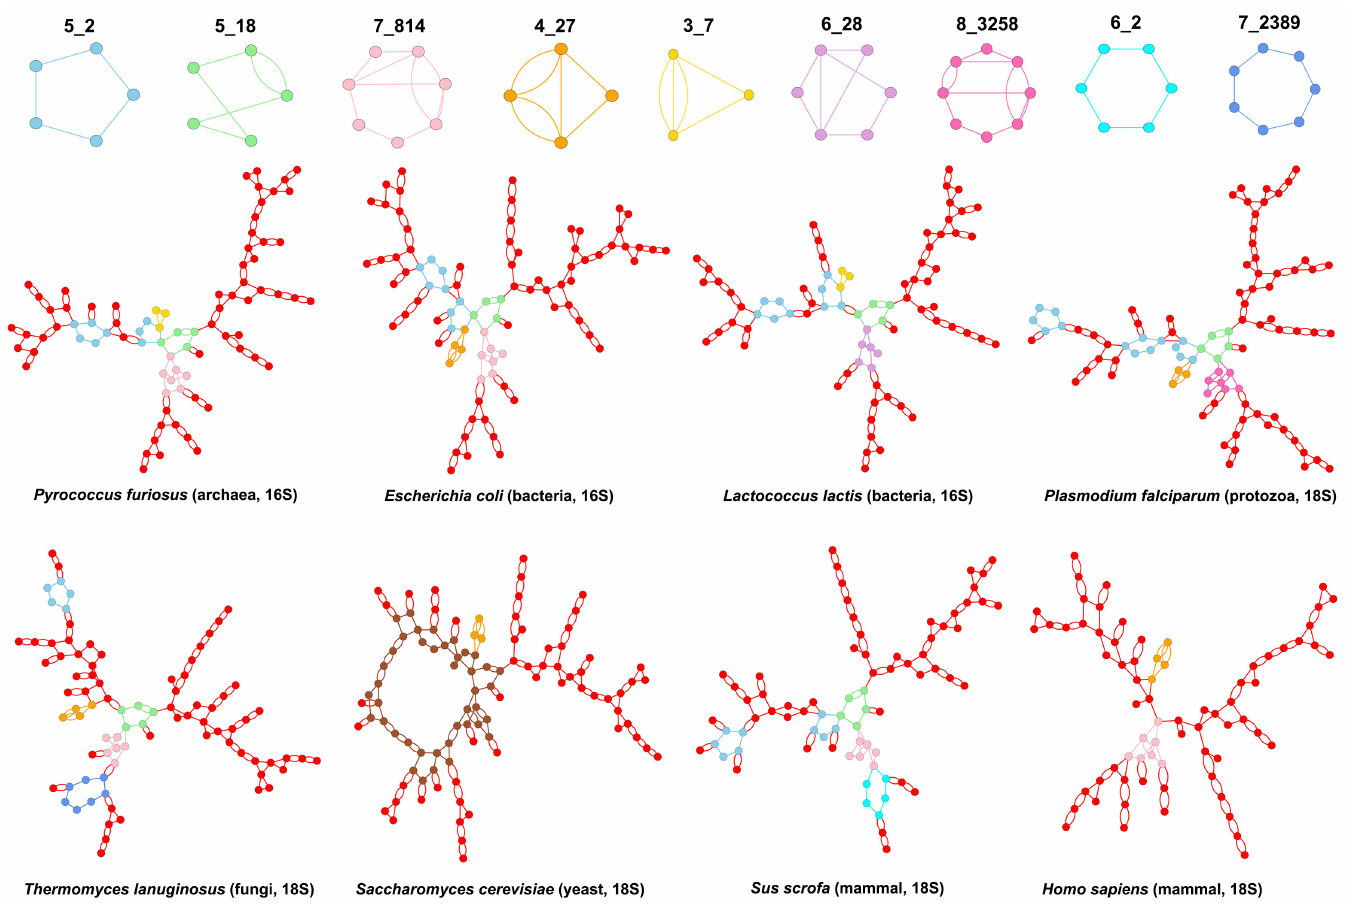
Figure 9. Dual graphs for small subunit rRNAs. Dual graphs corresponding to the 16S (prokaryotes) and 18S (eukaryotes) rRNAs of small ribosomal subunits for a few representative species. Different colors highlight different subgraph blocks. The subgraph block with 41 vertices in the dual graph of Saccharomyces cerevisiae is highlighted in brown. Smaller subgraphs that occur in large numbers (2_2, 3_5, 2_1, and 4_19) are all colored red and not highlighted